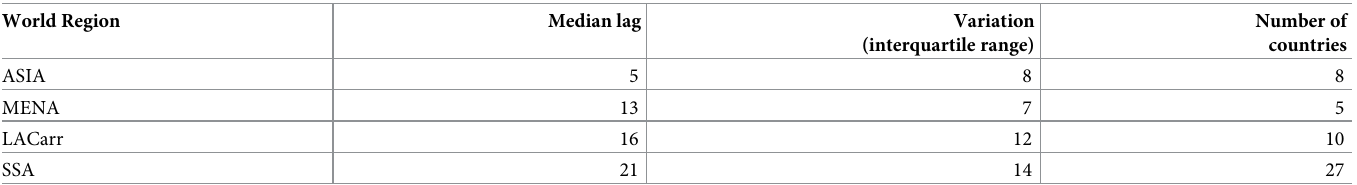
Number of (interquartile range) countries